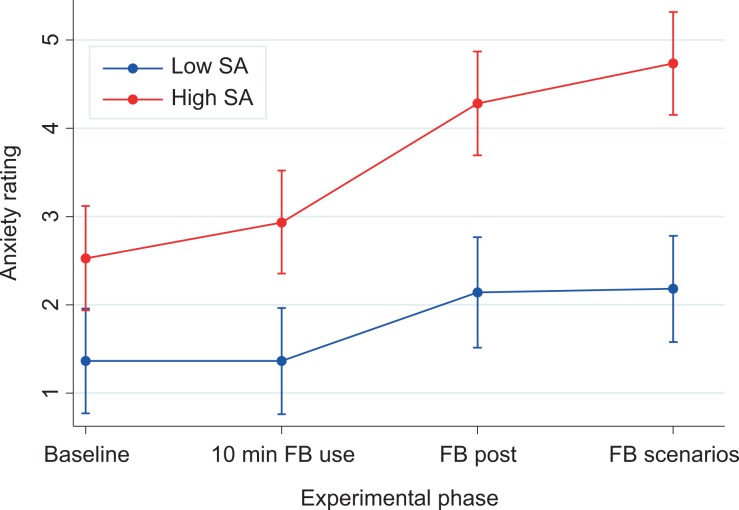
Anxiety ratings of participants from the low (blue) and high (red) SA groups across the four experimental phases with 95% confidence intervals. Anxiety ratings were made on a 0–10 scale (0 = not at all anxious, 10 = the most anxious I could feel). FB = Facebook, SA = social anxiety.